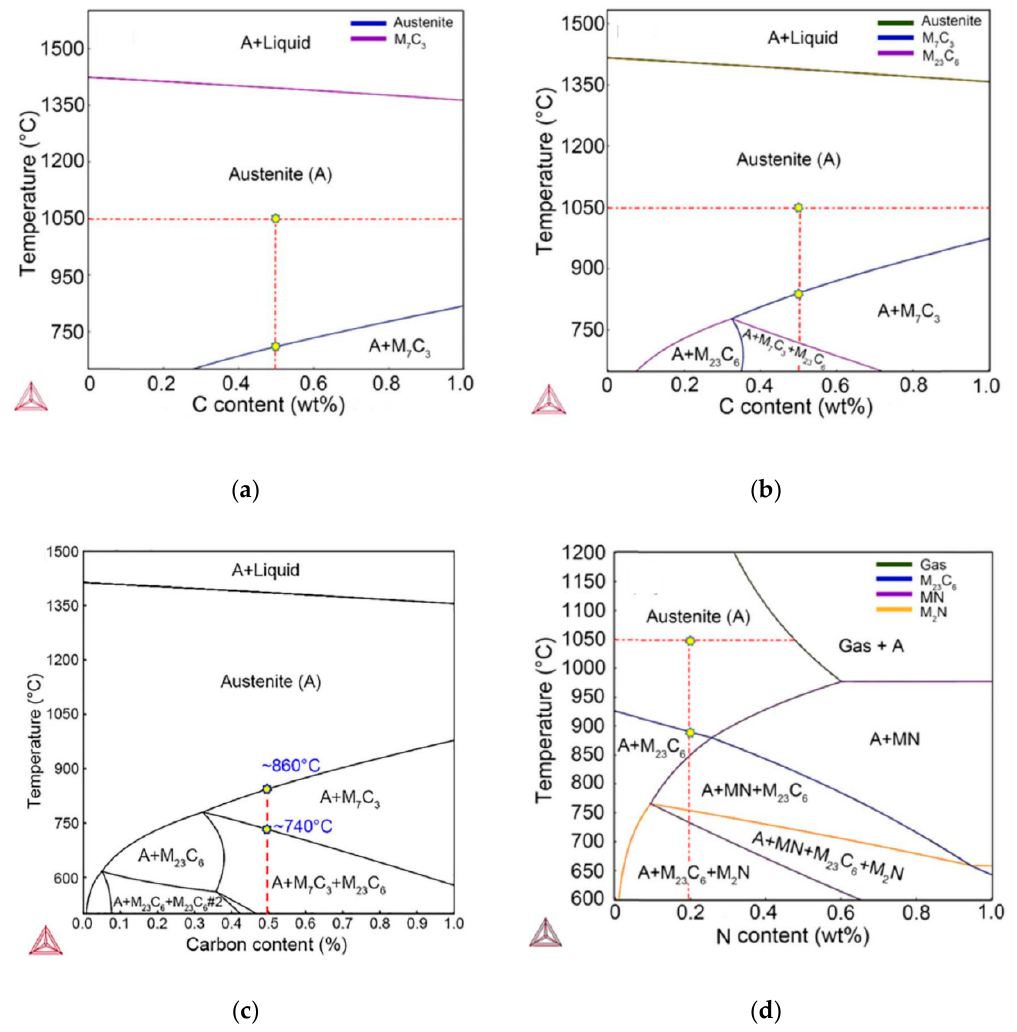
Figure 4. Phase equilibrium diagram of ( a ) 22Mn (Reprinted with permission from Ref. [6] Copy- right 2022 Elsevier), ( b ) 24Mn-3.3Cr [6], ( c ) 24Mn-3.4Cr (Reprinted with permission from Ref. [50] Copyright 2022 Elsever), and ( d ) 24Mn-6.3Cr-0.2 N [6] steels